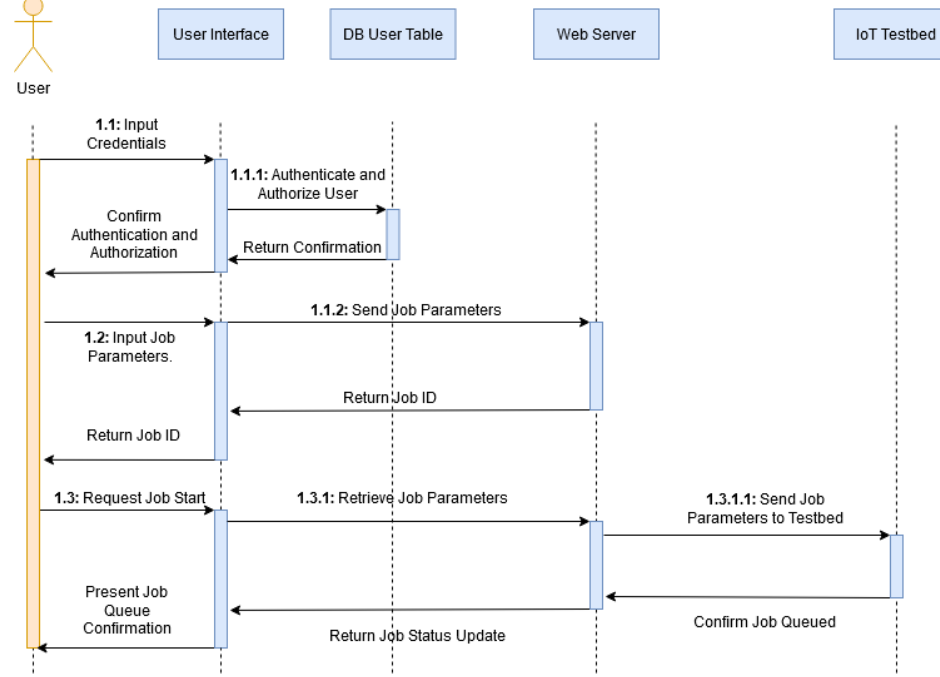
Figure 1. Job Queueing Sequence Diagram.